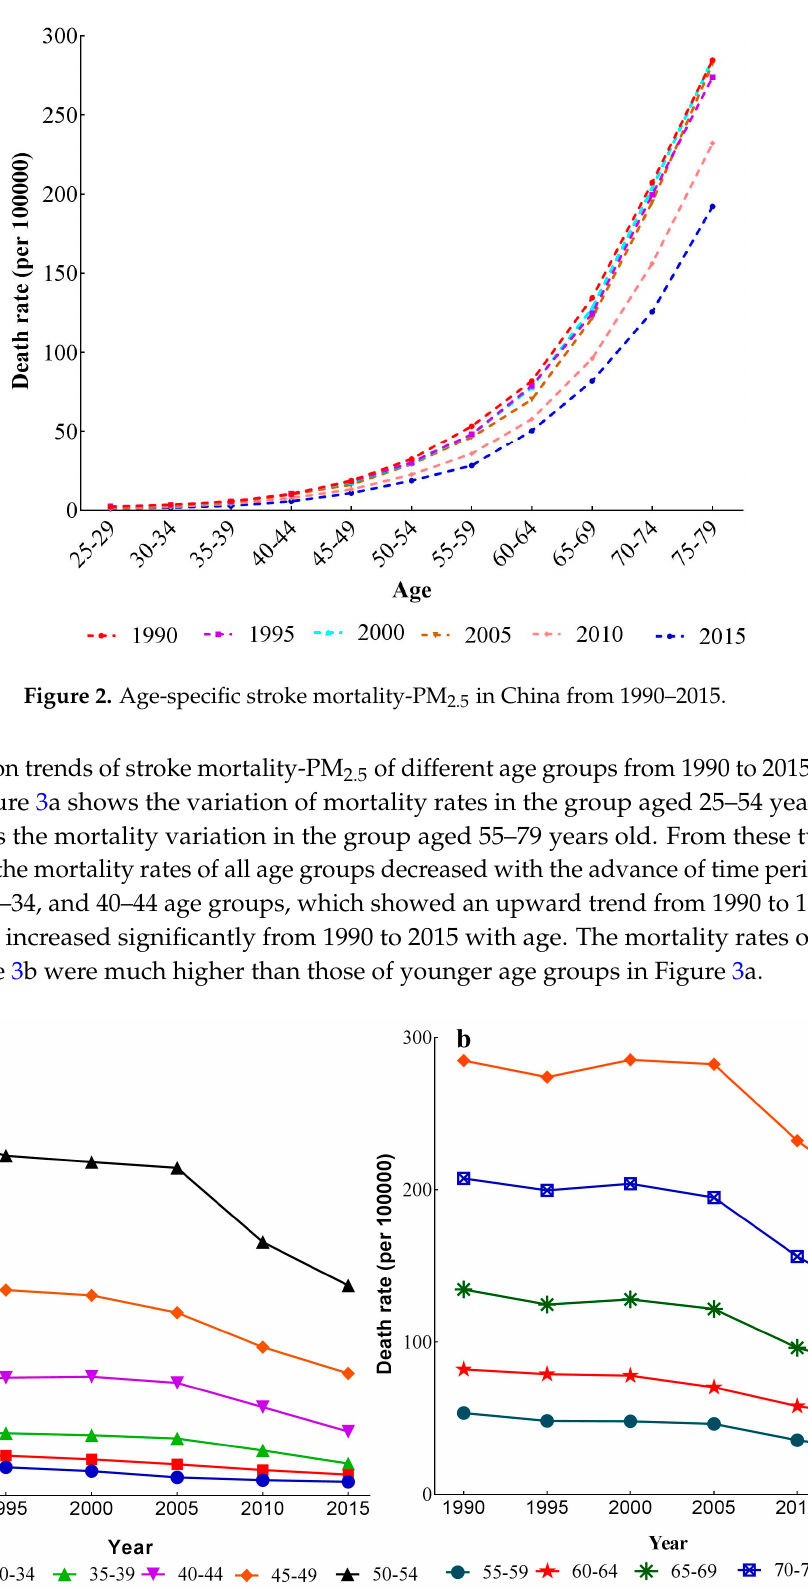
Figure 3. Stroke mortality-PM 2.5 among different age groups from 1990 to 2015. ( a ) 25–54 years old; ( b ) 55–79 years old.